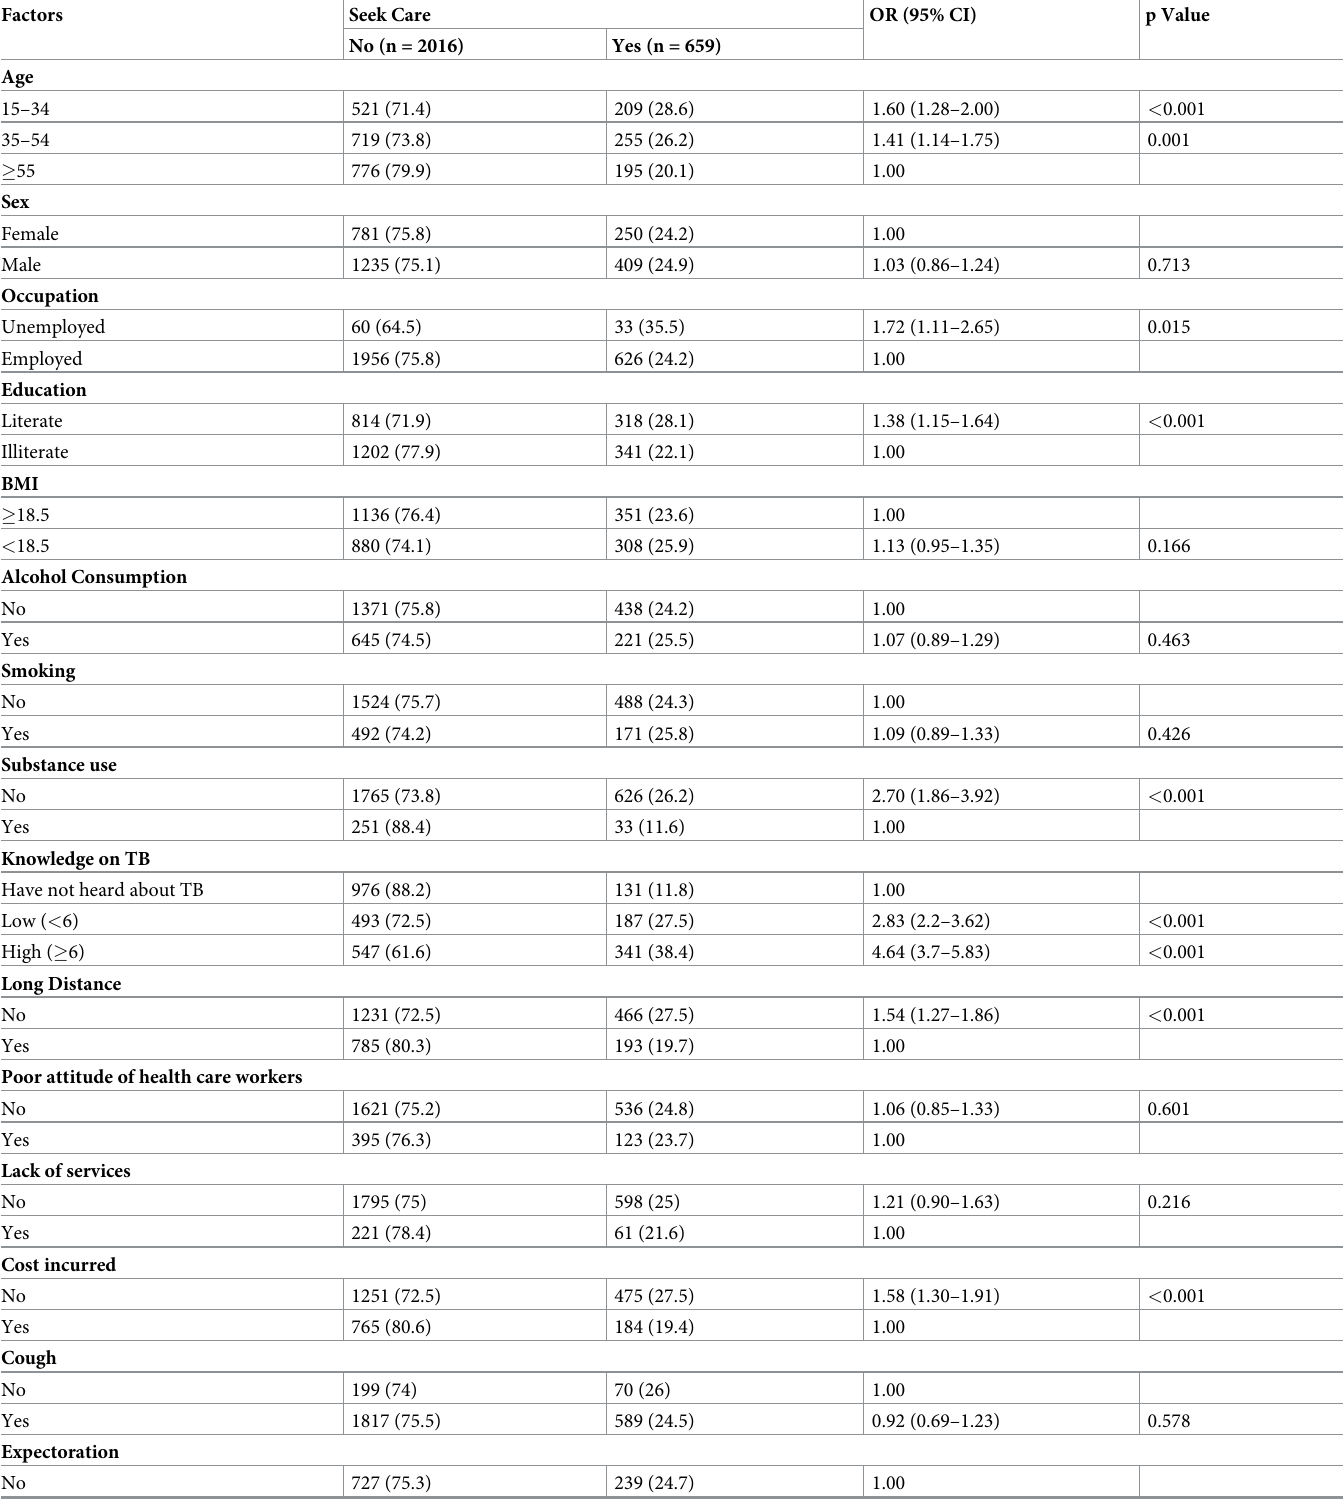
Table 2. Factors influencing Chest Symptomatic patients to seek care (n =